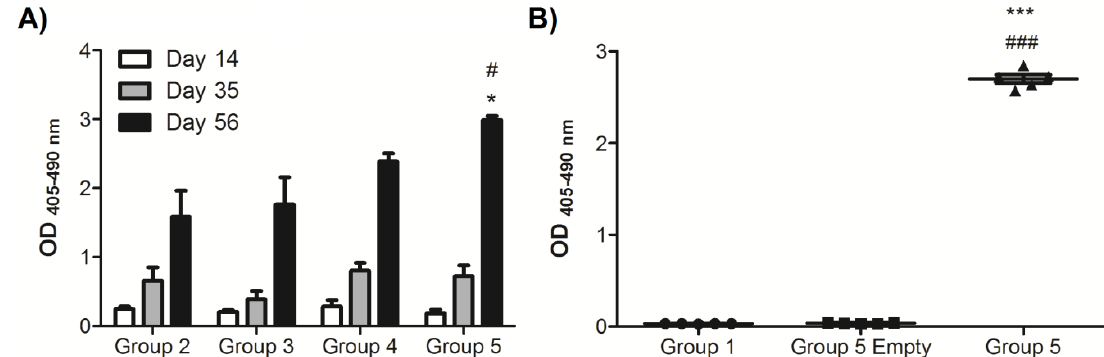
Figure 3. Levels of anti-nicotine IgG . Female BALB/c mice were administered intranasal installations of either PBS (Group 1) or different nicotine vaccine formulations: [BDA/Nic Hapten] (Group 2), [BDA/Nic Hapten /Chitosan] (Group 3), [BDA/Peptide 1 /Nic Hapten] (Group 4), and [BDA/Peptide 1 /Nic Hapten/Chitosan] (Group 5); Group 5 Empty refers to the delivery system without nicotine. Blood was collected two weeks post-vaccination (Day 14, 35, 56, and 77). ( A ) Anti-nicotine IgG from individual sera and diluted 1:300. Data are represented as ± SEM (n = 4–5 for each group). Statistical significance was determined by a Kruskal–Wallis with a Dunn’s multiple comparison test * p < 0.05 as compared to Group 2 and # p < 0.05 as compared to Group 3. ( B ) In a repeated trial, the total anti-nicotine IgG present was detected in sera (1:600 dilution). Each point represents an individual mouse and data are represented as ± SEM, n = 5. Statistical significance was determined by an ANOVA with a Tukey HSD. *** p ≤ 0.001 as compared to Group 1 and ### p ≤ 0.001 as compared to Group 5 Empty.